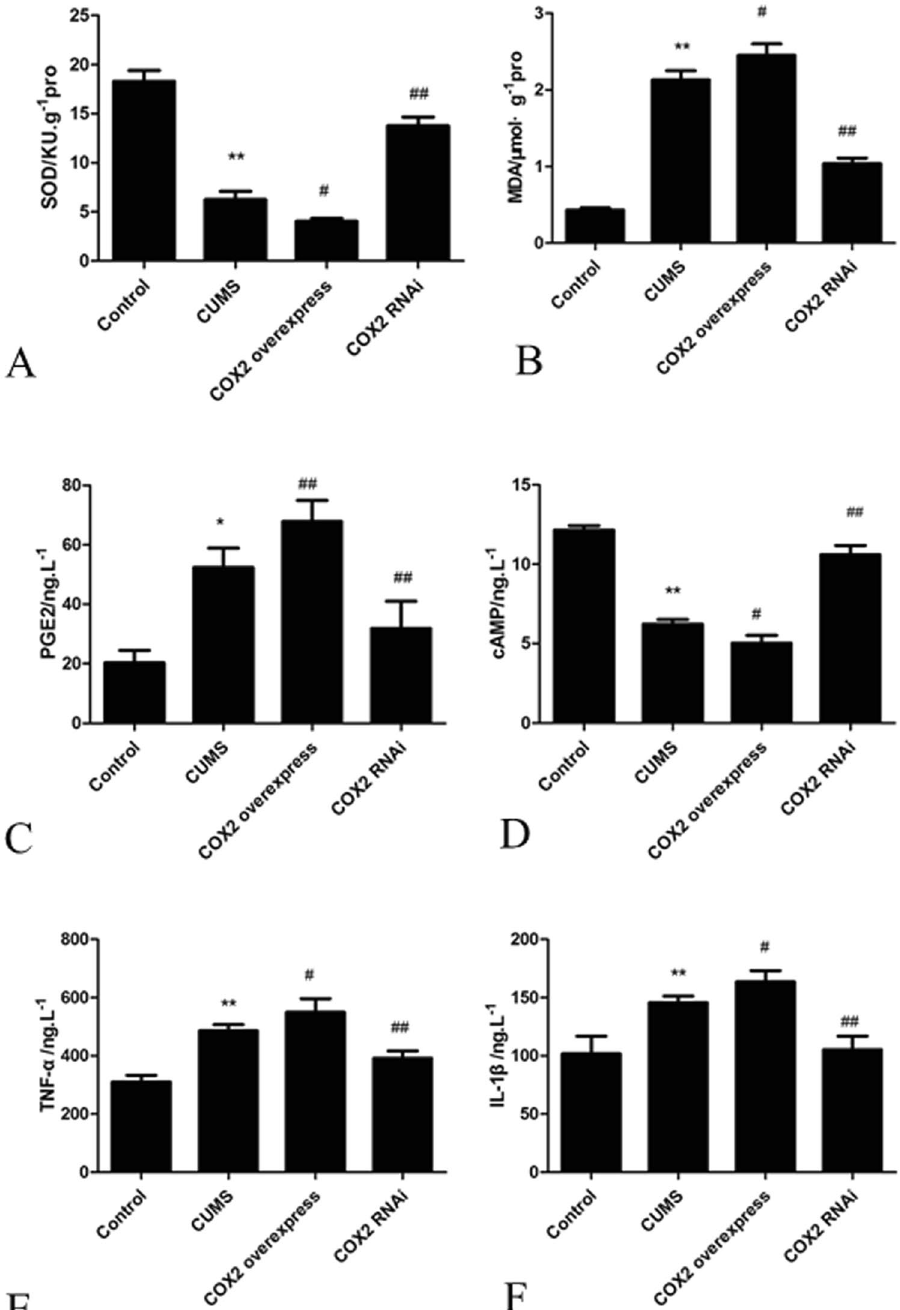
Figure 6. Effects of COX2 overexpression and RNAi on the changes in SOD activity and the levels of MDA, PGE2, cAMP, TNF- α and IL-1 β in CUMS rat cortices. ( A ) The SOD activity. ( B ) The MDA content. ( C ) The PGE2 content. ( D ) The cAMP concentration. ( E ) The TNF- α content. ( F ) The IL-1 β content. Group data shows the changes in SOD activity and the levels of MDA, PGE2, cAMP, TNF- α and IL-1 β in CUMS rat cortices. Data are expressed as the mean ± SD in six separate experiments. Compared with the control group, the activity of SOD and the concentration of cAMP significantly decreased in the CUMS group, while the contents of MDA, PGE2, TNF- α and IL-1 β significantly increased. Compared with those in the CUMS group, the activity of SOD and the concentration of cAMP decreased significantly, and the contents of MDA, PGE2, TNF- α and IL-1 β significantly increased in the COX2 overexpressed group. The activity of SOD and the concentration of cAMP significantly increased in the COX2 RNAi group, while the contents of MDA, PGE2, TNF- α and IL-1 β significantly decreased. * P < 0.05 and ** P < 0.01 vs the control group, respectively. # P < 0.05 and ## P < 0.01 vs the CUMS group,